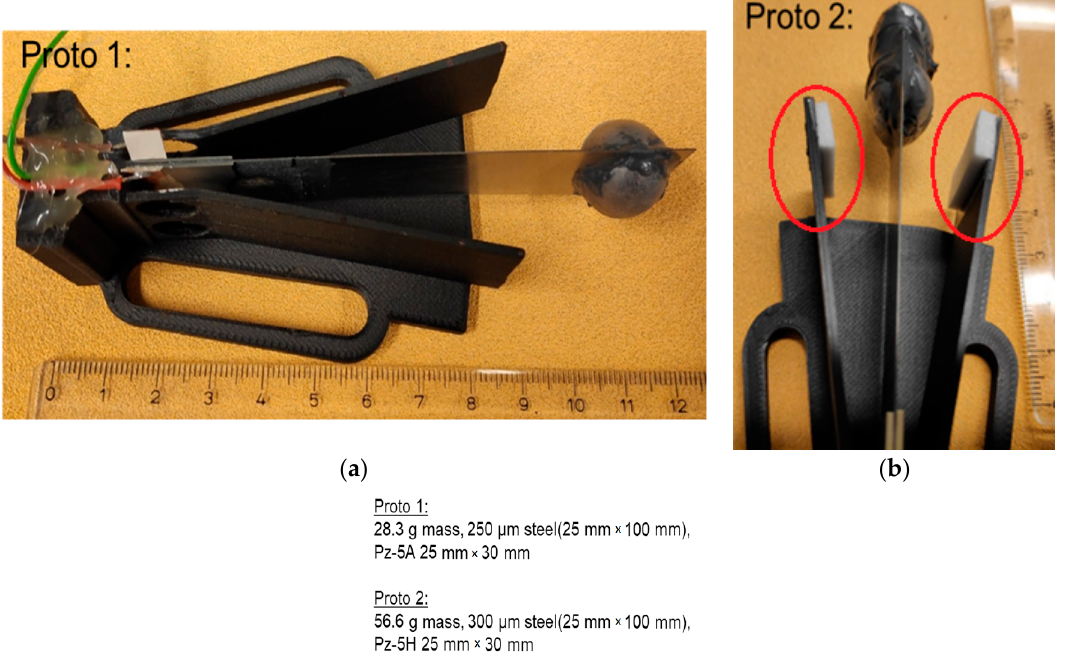
Figure 10. Piezoelectric cantilever prototypes with ( a ) a 28.3 g and ( b ) a 56.6 g tungsten